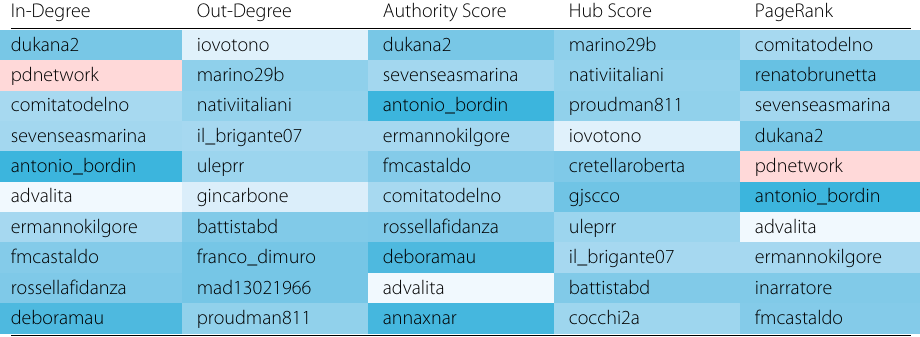
Table 3 PI2 retweet graph: top 10 accounts by centrality In-Degree